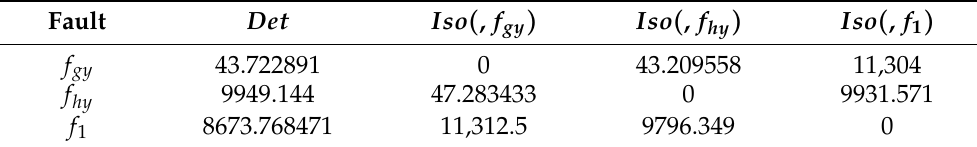
Table 2. Diagnosability indexes based on the KLD for the three types of faults.